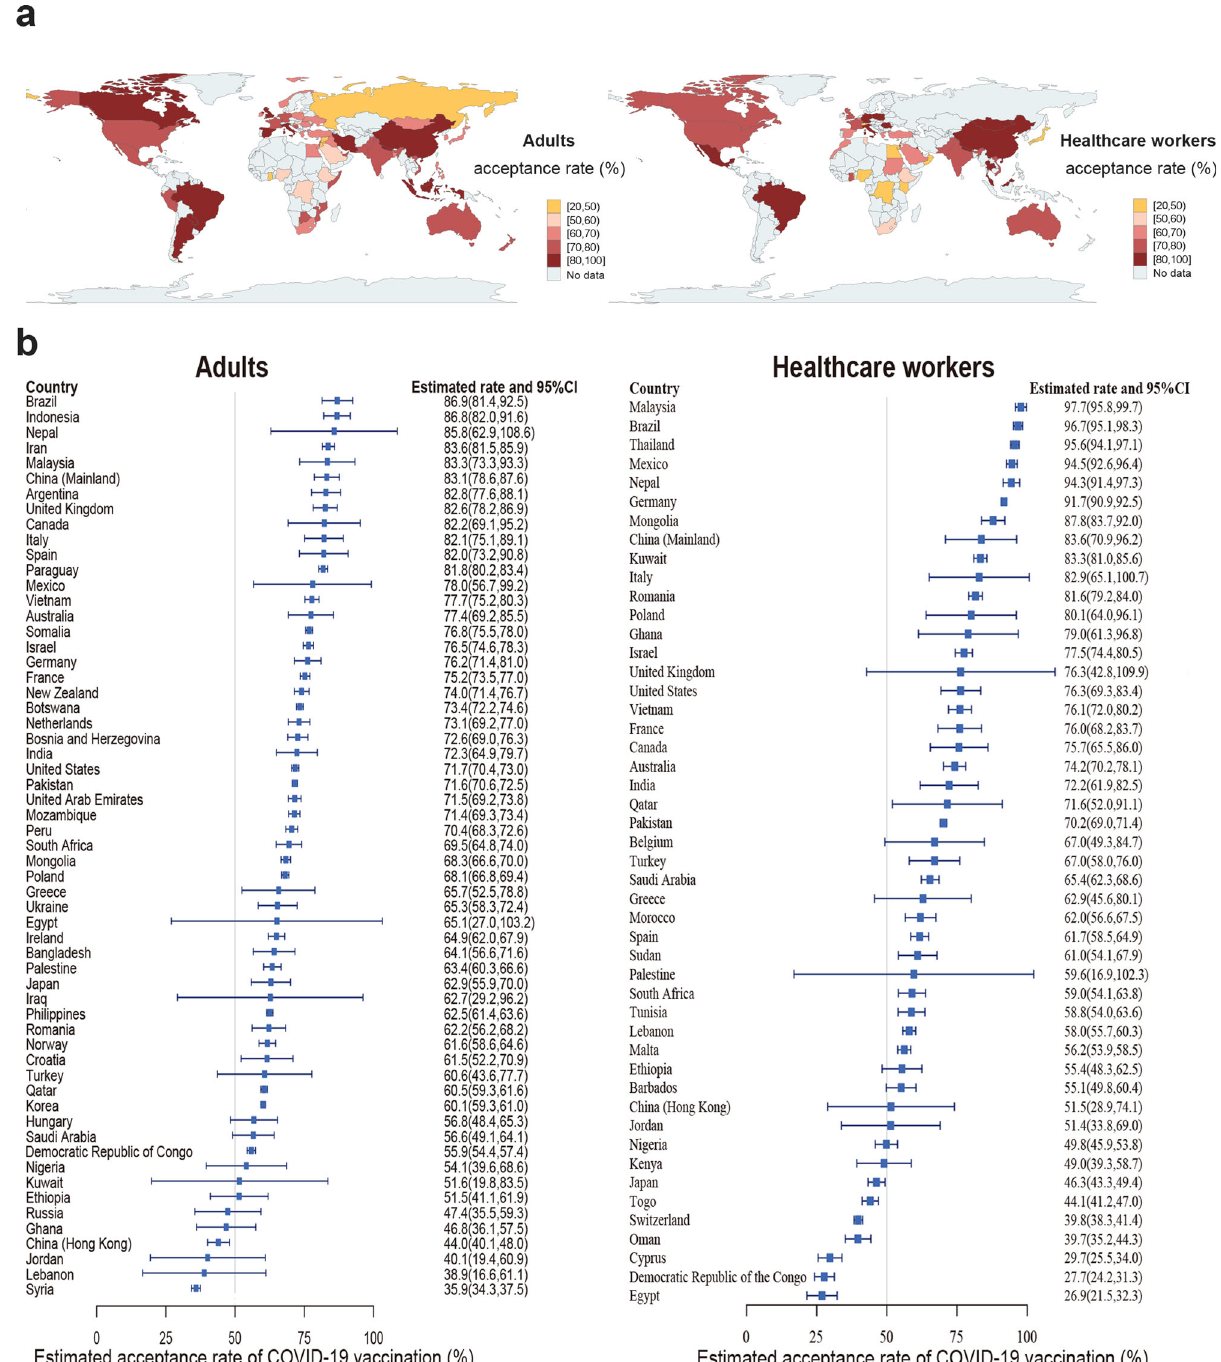
Fig. 2 Estimated COVID-19 vaccination acceptance rates among adults and healthcare workers worldwide (%). a Estimated COVID-19 vaccination acceptance rates among adults ( n = 6,538,325) and healthcare workers ( n = 128,515) across countries are shown via map. Different colors refer to different levels of acceptance rates. b Estimated COVID-19 vaccination acceptance rates and 95% con fi dence interval (CI) in adults ( n = 6,538,325) and healthcare workers ( n = 128,515) across countries are